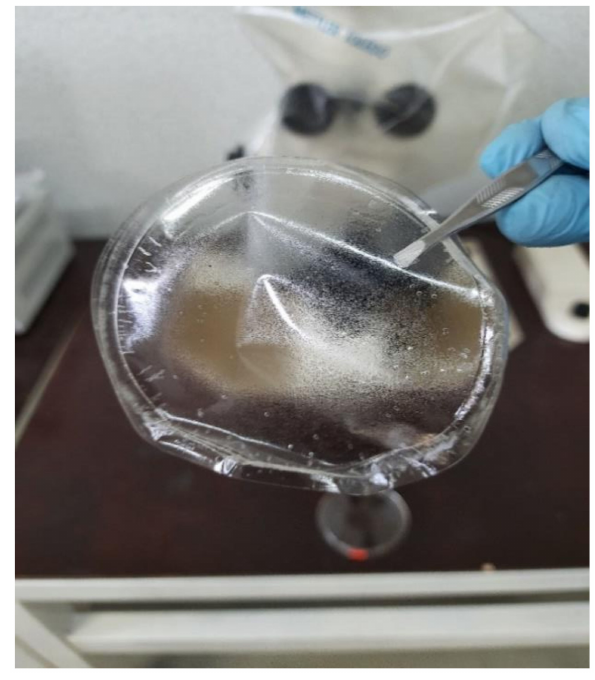
Figure 1. MC/PVP SPE